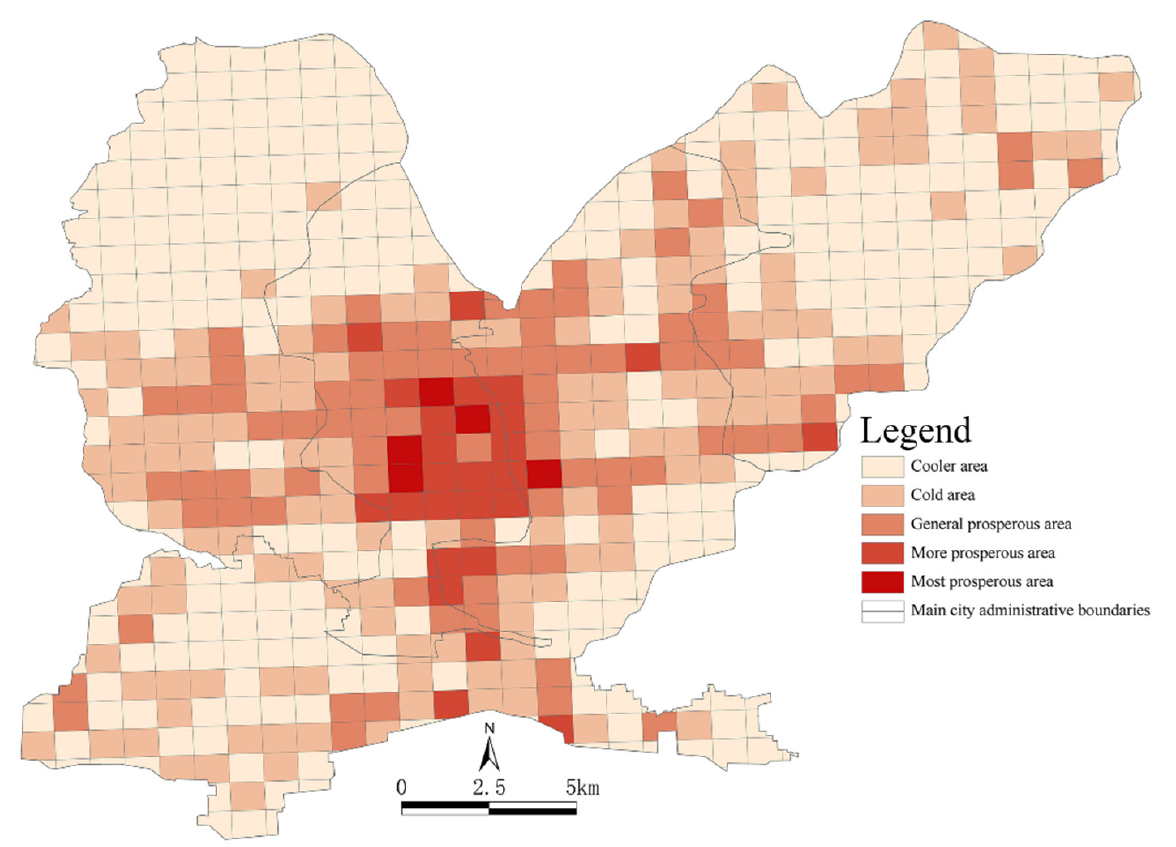
Figure 10. The travel vitality index of urban residents in the main urban area in Jiaozuo. Table 4. The public awareness of POIs.